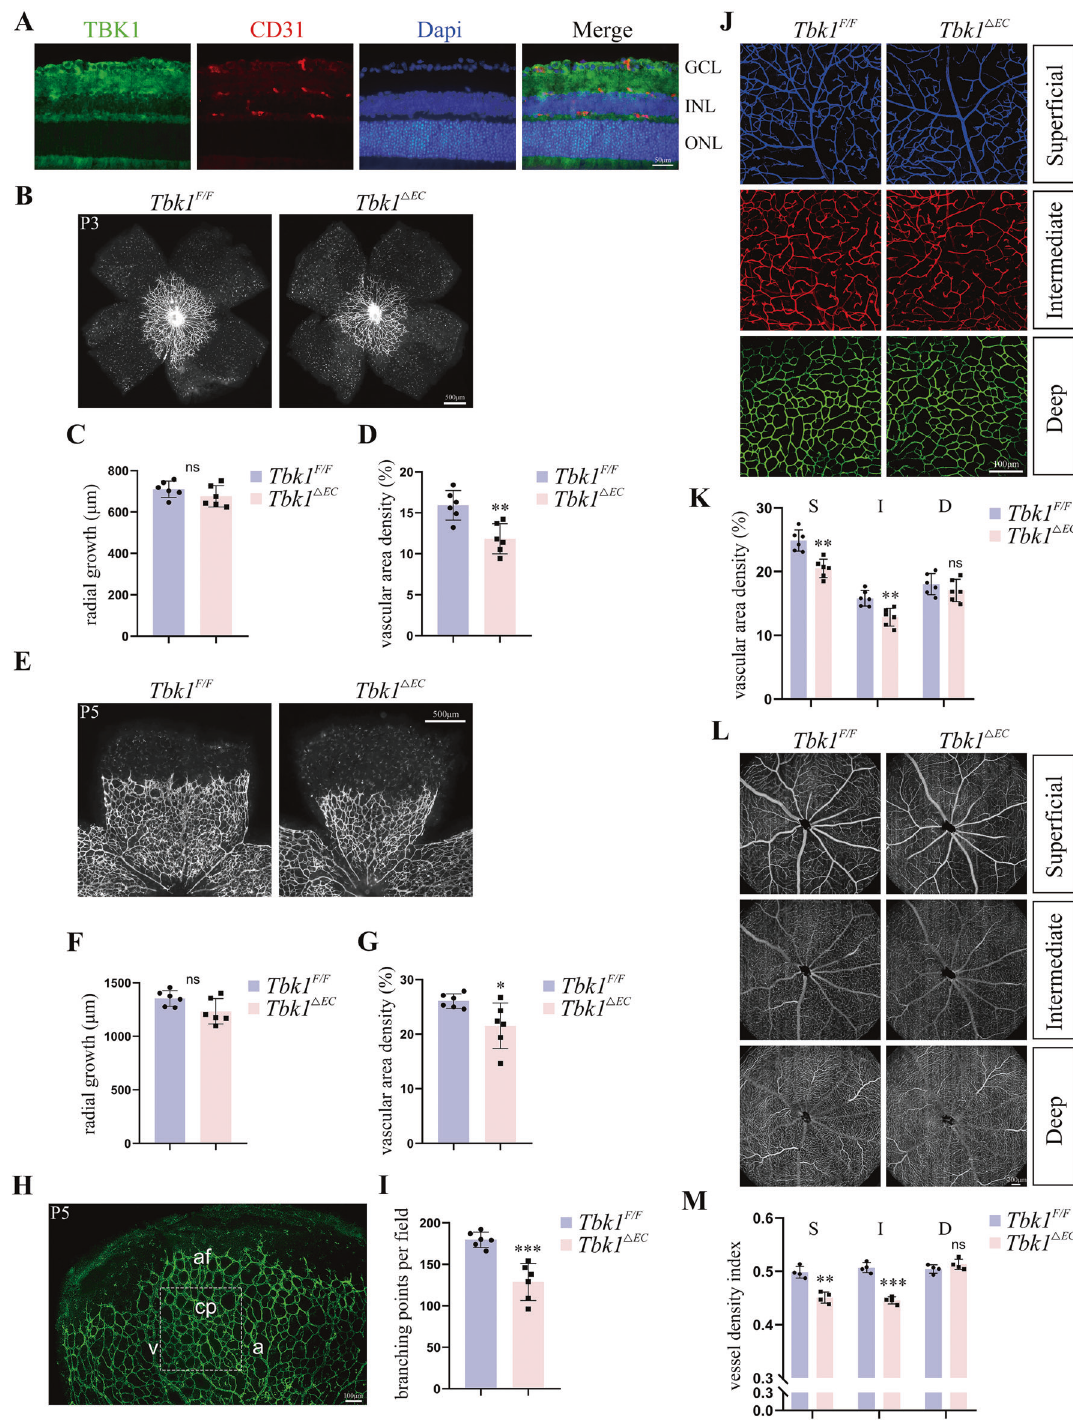
Fig. 1 The effect of endothelial TBK1 deletion on retinal vascular development. A Immuno fl uorescence images of retinal cross-section stained with TBK1 and CD31. B Whole-mount IB4 labeling of retinal vasculature of P3 Tbk1 F/F and Tbk1 Δ EC littermates. C , D Quanti fi cation of vascular radial growth ( C ) and vascular density ( D ) in B . The data were means±SD of six retinas/group and assessed by student ’ s t -test. E Whole-mount IB4 labeling of retinal vasculature of P5 Tbk1 F/F and Tbk1 Δ EC littermates. F Quanti fi cation of vascular radial growth in E . The data were means±SD of six retinas/ group and assessed by student ’ s t -test. G Quanti fi cation of vascular density in E . The data were means±SD of six retinas/group and assessed by Welch ’ s t -test. H Representation of the region (dashed-line square) where branching points were analyzed. Indicating a capillary plexus close to the edge of the angiogenic front between an arteriole and a venule. af angiogenic front, cp capillary plexus, a arteriole, v venule. I Quanti fi cation of branching points in capillary plexus of P5 Tbk1 F/F and Tbk1 Δ EC mice. The data were means±SD of six retinas/group and assessed by student ’ s t -test. J Representative whole-mount IB4 labeling of retinal vasculature of P18 Tbk1 F/F and Tbk1 Δ EC littermates. Pseudo color for distinguishing super fi cial, intermediate, and deep plexuses. K Quanti fi cation of vascular density in J . The data were means±SD of six retinas/group and assessed by multiple t -test. L OCTA images of retinal vascular plexuses in adult Tbk1 F/F and Tbk1 Δ EC mice. M Analysis of vessel density index in vascular plexuses in L . The data were means±SD of four retinas/group and assessed by multiple t -test. * P <0.05, ** P <0.01, *** P <0.001. Cell Death Discovery (2022)